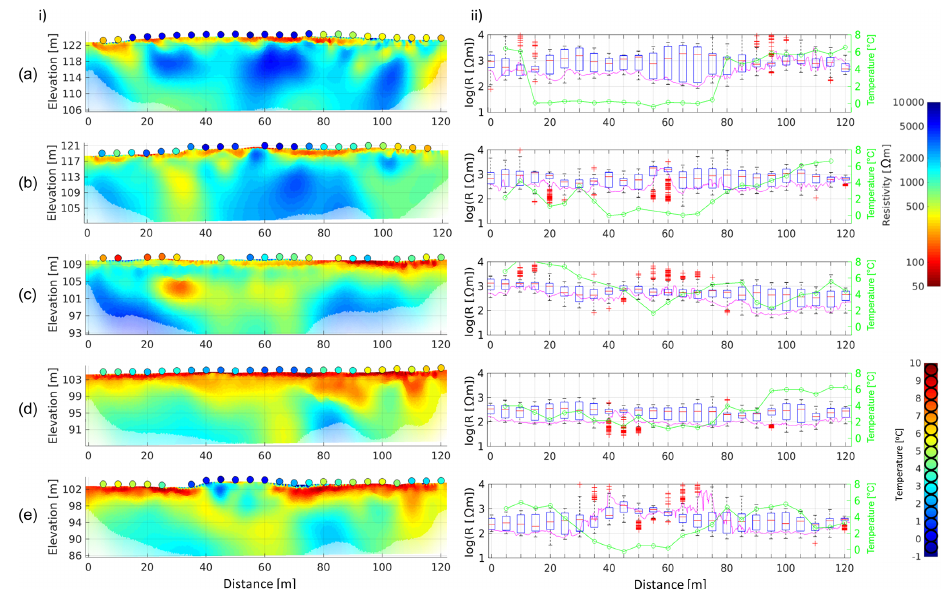
Figure 6. (i) ERT data with soil temperature at 0.8m depth (extracted from the DTP dataset from 17 July 2017) shown at the top of each transect; (ii) boxplots of the resistivity values in the top 7m depth, vertically averaged resistivity in the top 0.8m (purple line), and temperature at 0.8m depth (green